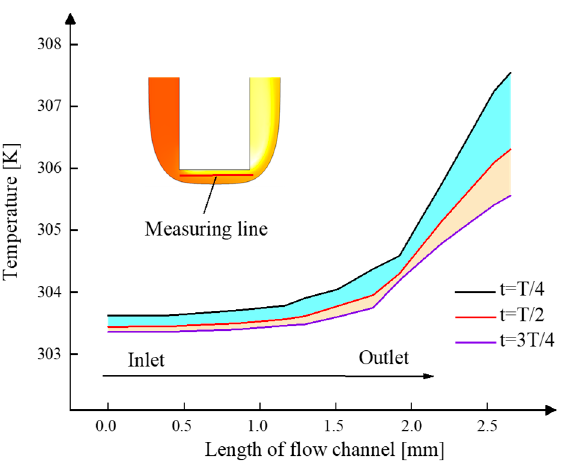
Figure 8. Temperature distribution of electrolyte near the cathode.